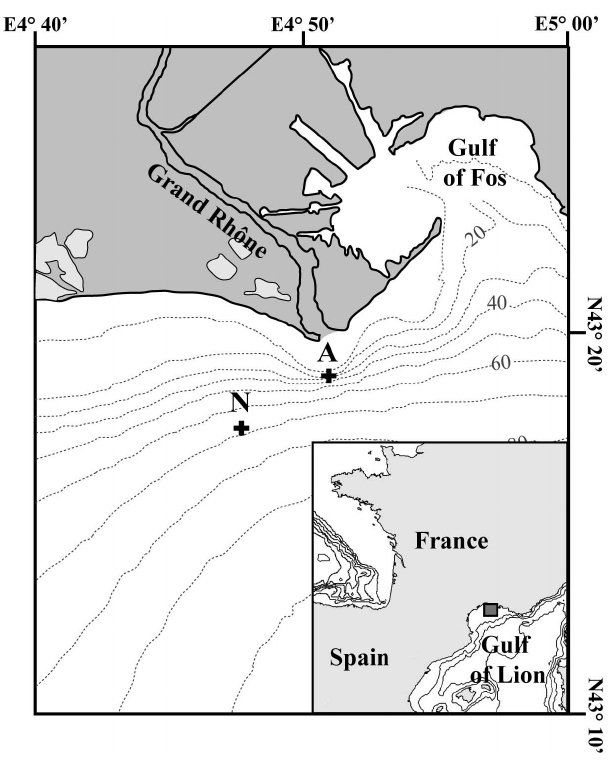
Fig. 1. Study area and location of both investigated Stations A and